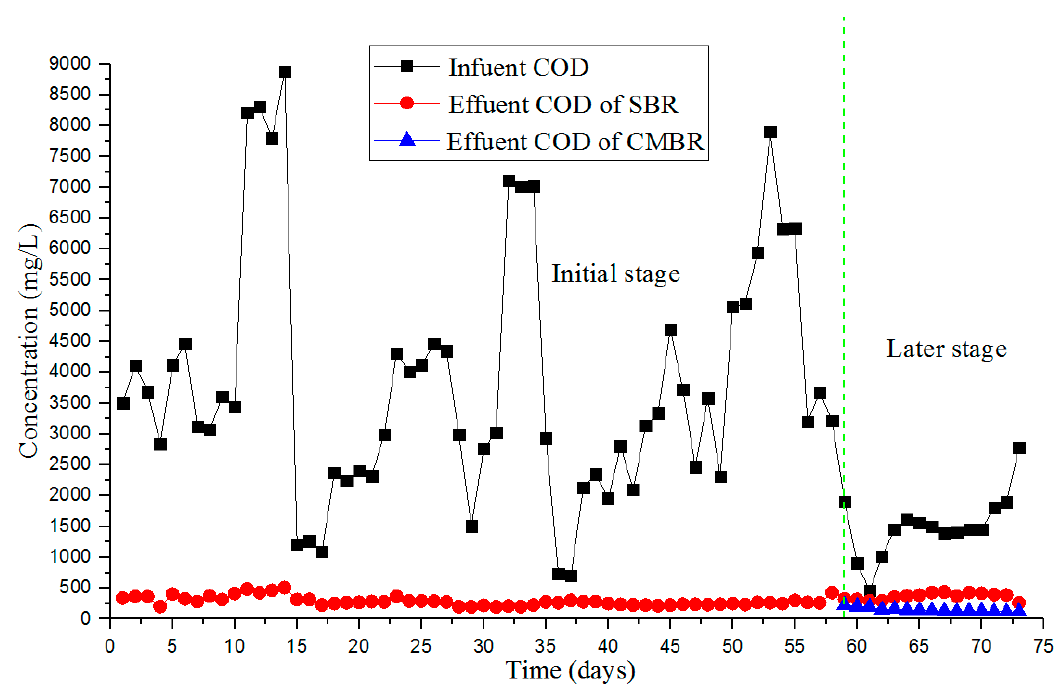
Figure 3. The chemical oxygen demand (COD) removal performance during the debugging period.